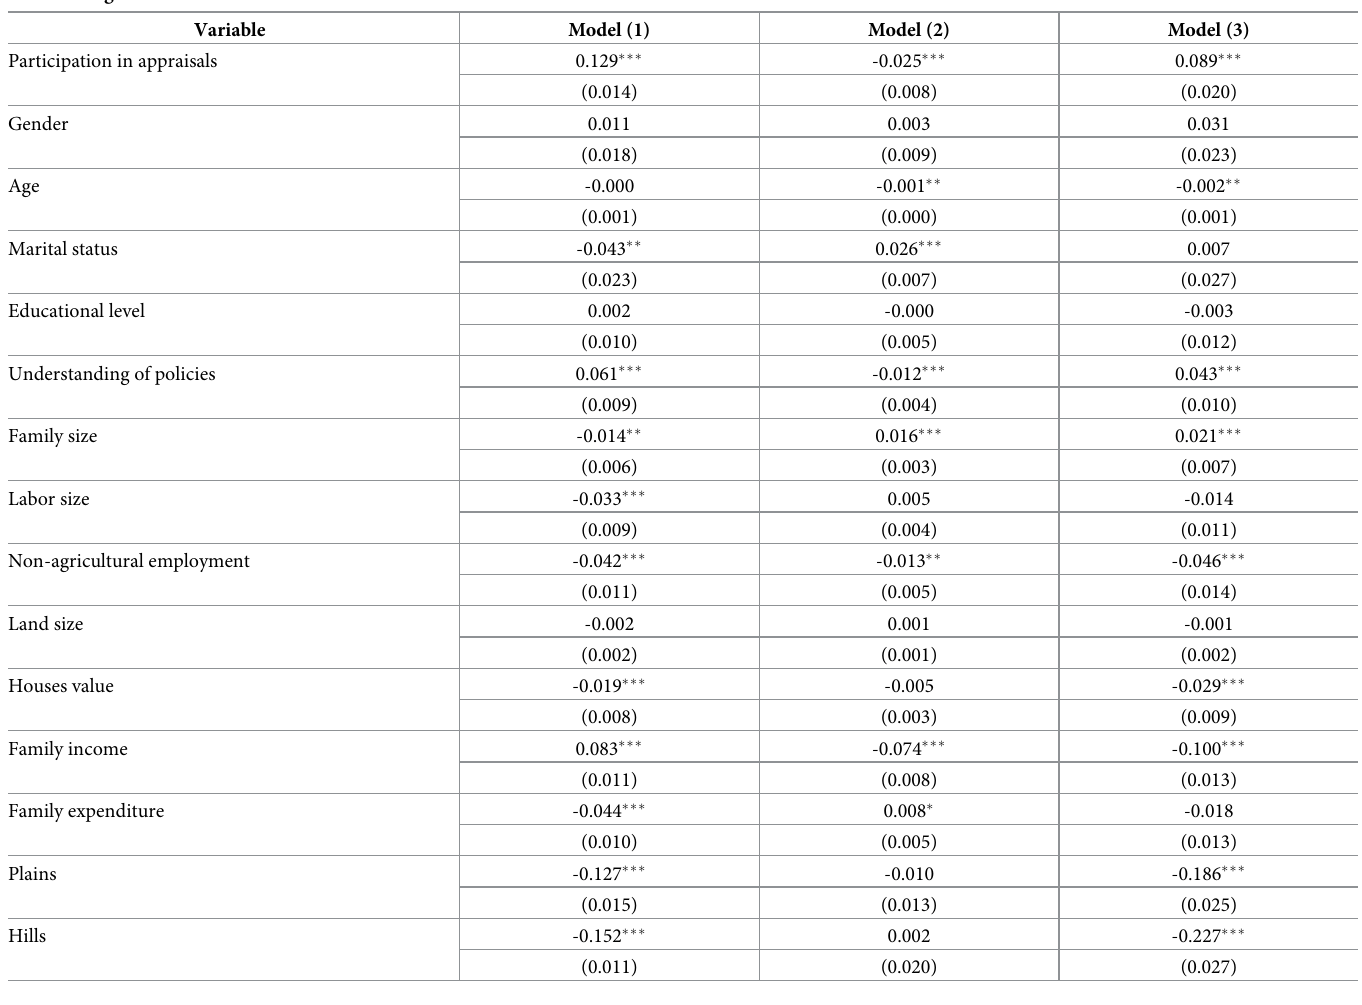
Table 3. Regression